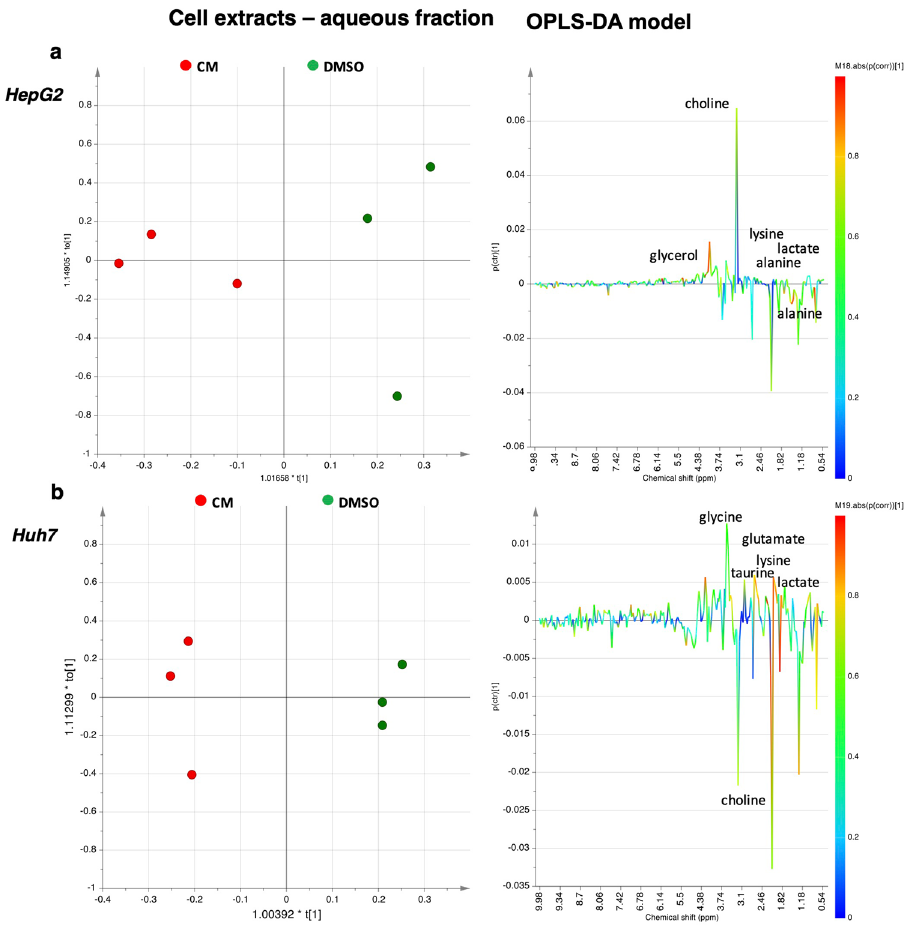
Figure 3. OPLS-DA scores plots (left panel) and corresponding coefficient loading plots (right panel) derived from the 1 H-NMR spectra of HepG2 ( a ) and Huh7 ( b ) cell extracts aqueous fraction obtained from different groups. DMSO Vehicle treatment, CM Crithmum maritimum